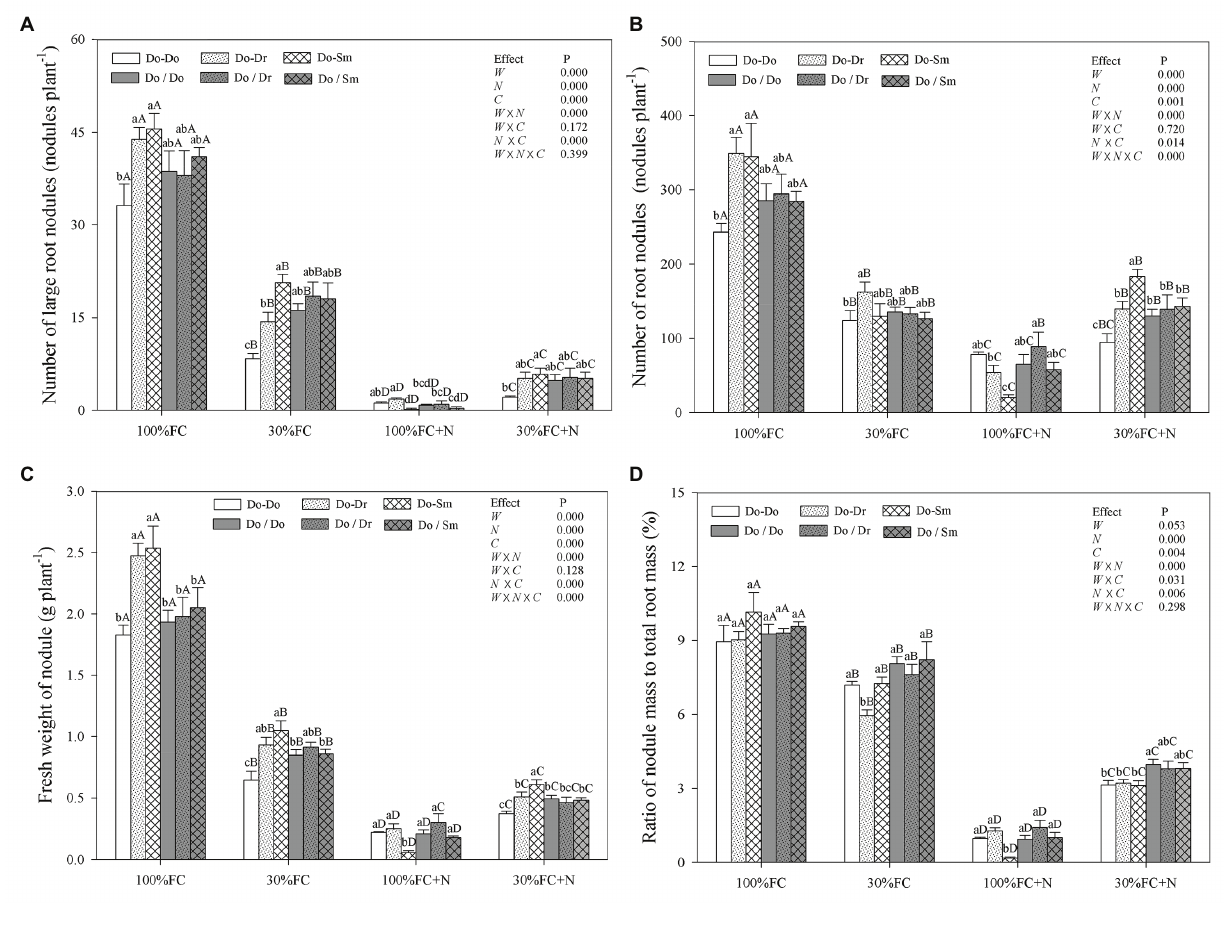
FIGURE 4 | Effects of water, N fertilization levels, and species competition models on large nodules number (A) , total nodules number (B) , fresh nodules weight (C) , and the ratio of nodules mass to root mass (D) of D. odorifera . Different lowercases in each graph indicate significant difference among different competitive models (competition between D. odorifera and various N-fixing niche neighbors) under the same water and N application according to Duncan’s tests ( p < 0.05). Different uppercases in each graph indicate significant difference among different water and N fertilization application in the same competitive models according to Duncan’s tests. For abbreviations explanation of treatments (species competition models, water, and N fertilization), data description, and statistics are the same as shown in Figure 1